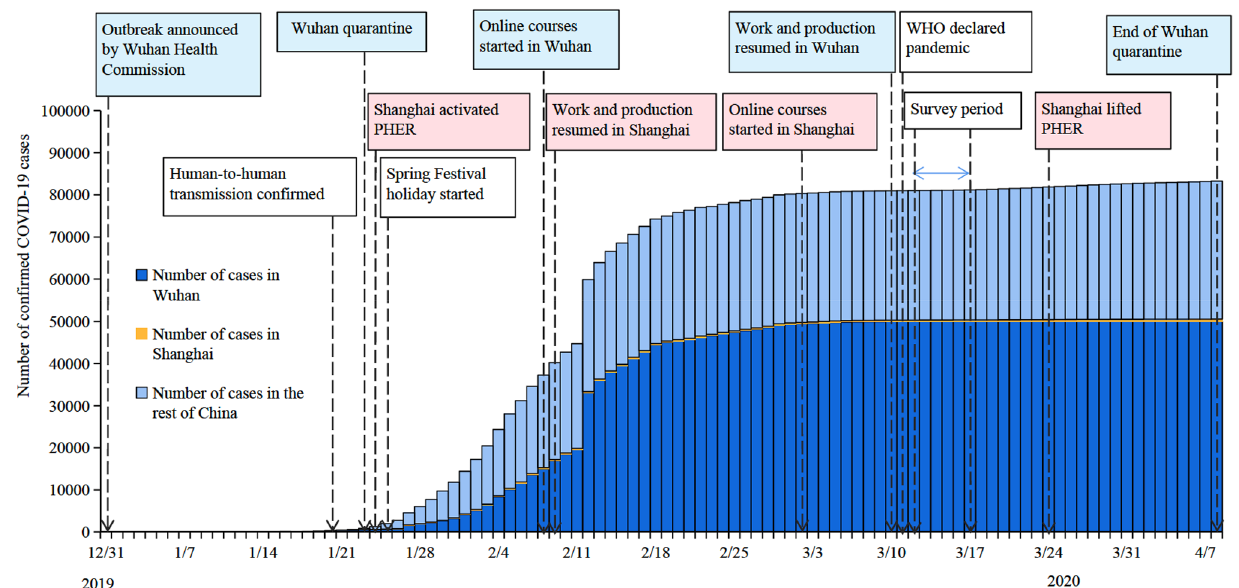
Figure 1. The timeline of the COVID-19 epidemic progression and quarantine measures in Wuhan and Shanghai. Note: PHER: public health emergency